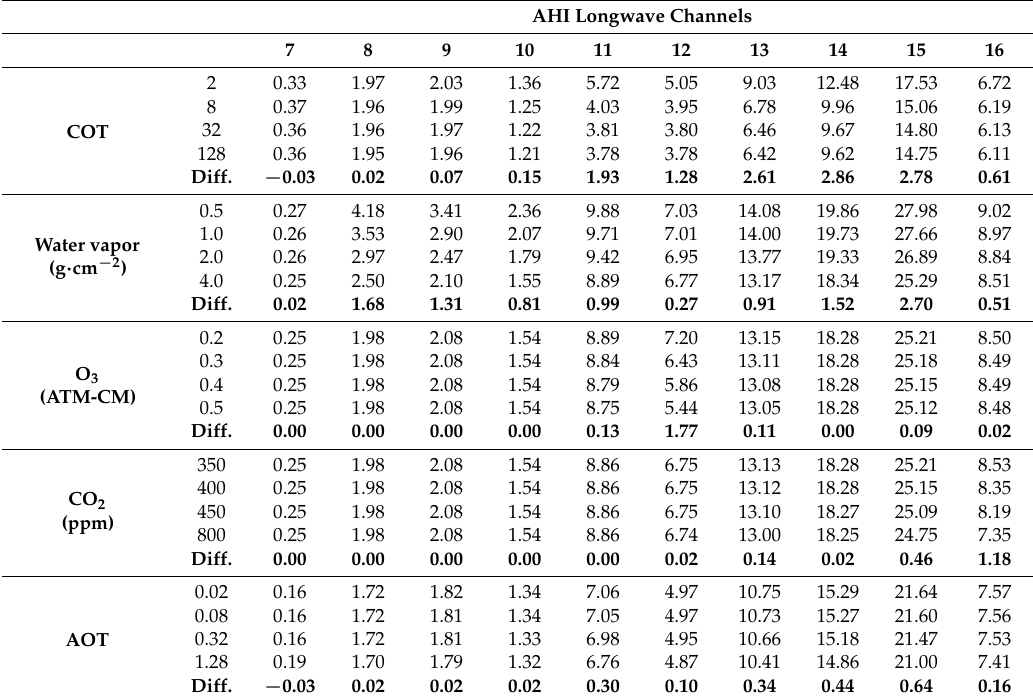
Table 3. Changes in OLR based on COT, AOT and concentration of absorption gases (water vapor, O 3 , and CO 2 ) for each channel in the AHI. “Diff.” is the difference between the maximum and minimum radiation of the sensitivity test for each condition.